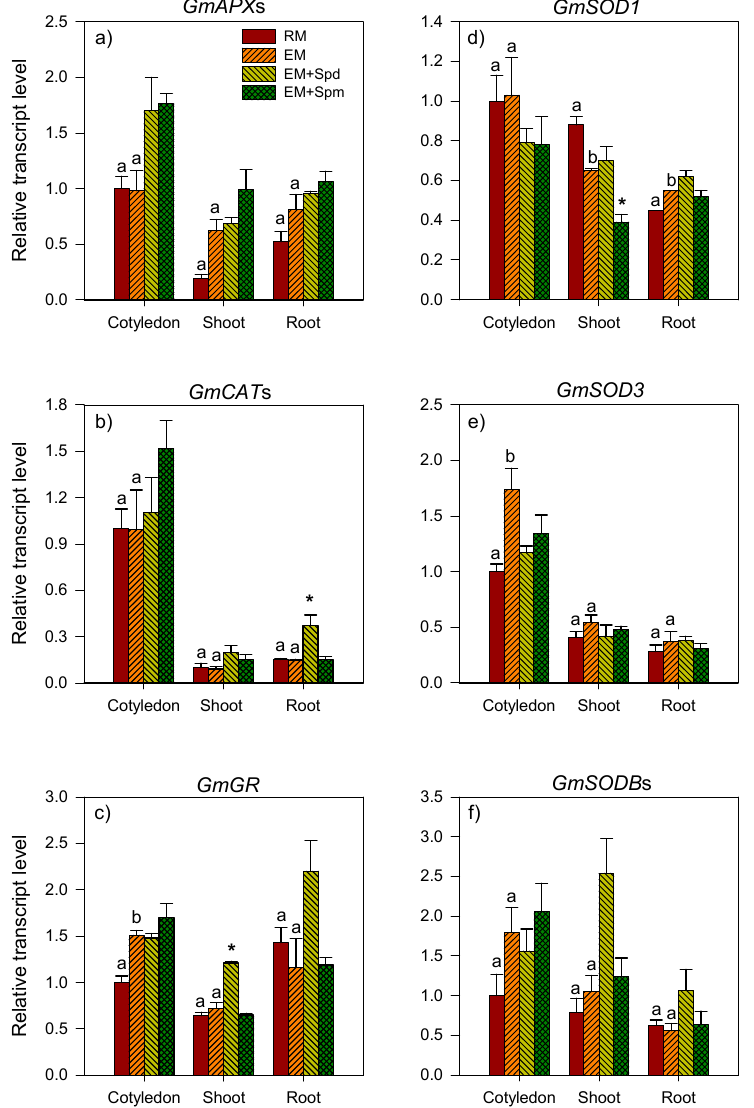
Figure 5. Expression of the genes encoding antioxidative enzymes in the tissues of 7 DAP seedlings. Relative transcript levels of GmAPX s ( a ), GmCAT s ( b ), GmGR ( c ) and the members of the GmSOD gene family, GmSOD1 ( d ), GmSOD3 ( e ) and GmSODB s ( f ) in the cotyledon, shoot and root tissues of seedlings under regular watering (RM) and excess moisture (EM) conditions, with or without